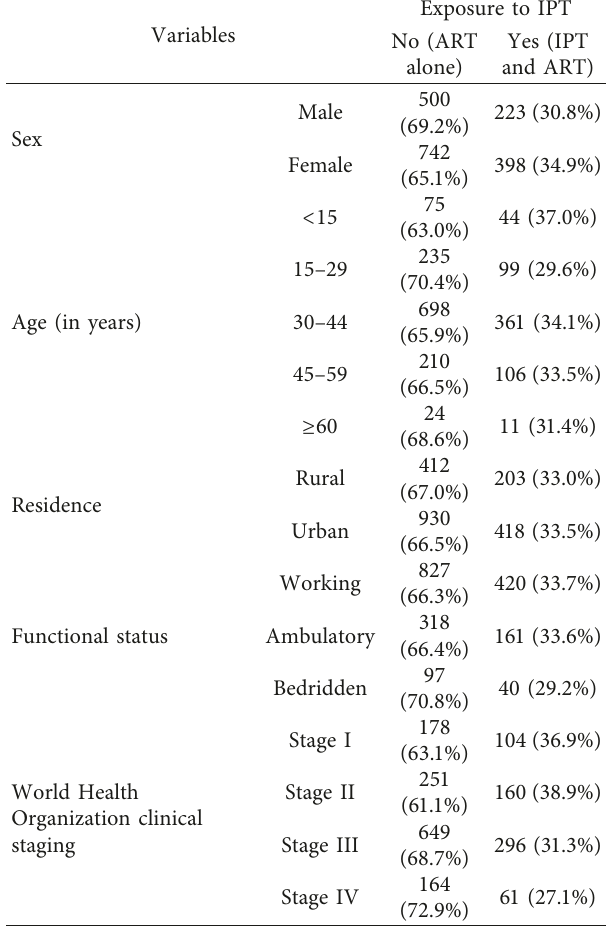
Table 1: Baseline sociodemographic and clinical characteristics of patients living with HIV/AIDS in Northern Ethiopia,